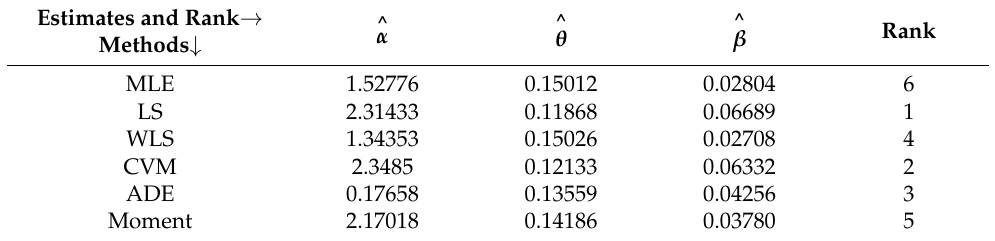
Table 7. The estimators and ranks for the GRC model under the claims data for all estimation methods. Estimates and Rank →